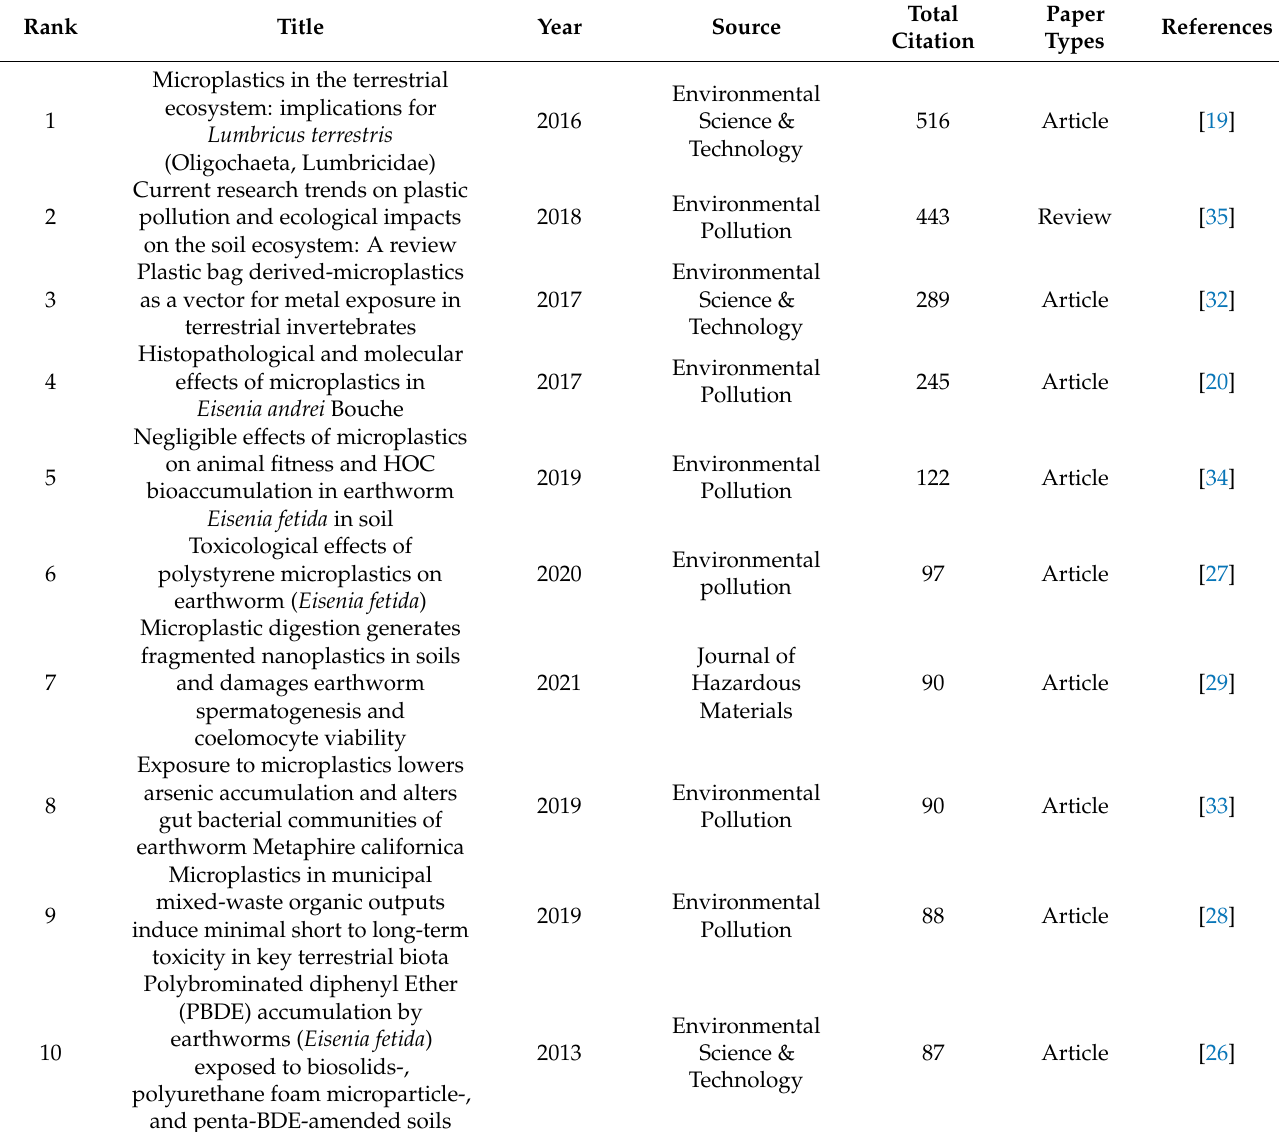
Table 2. Top 10 highest cited papers in terms of citation frequency in the field of micro(nano)plastic toxicity in